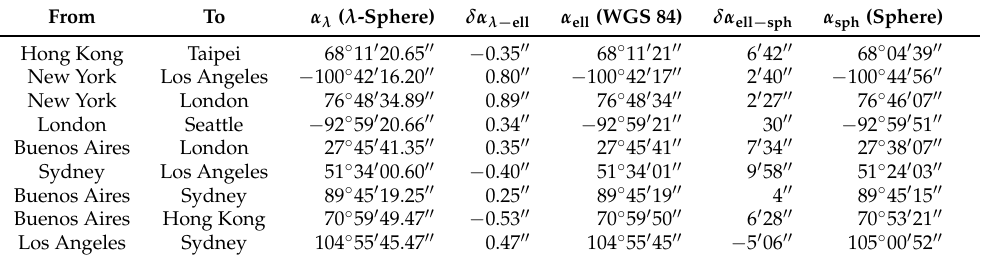
Table 2. Comparison of values for azimuths calculated from the inverse problems for loxodromes based on the λ -sphere’s, WGS 84 ellipsoidal, and spherical reference models for the geoid. From To α λ ( λ -Sphere)